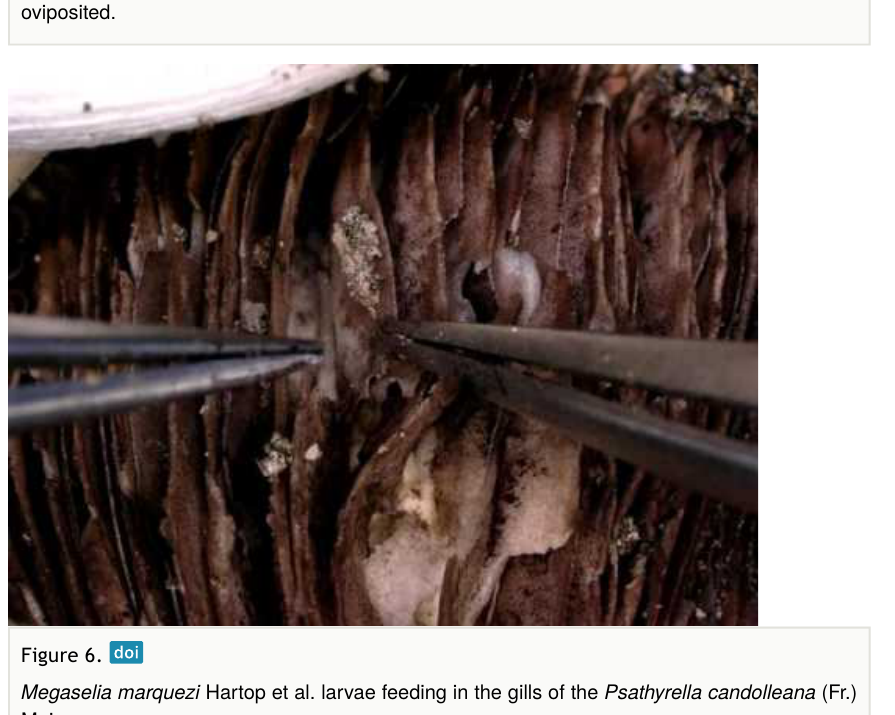
Figure 5. Megaselia marquezi Hartop et al. inside the broken-open cap of a closed Psathyrella candolleana (Fr.) Maire. Based on the extended abdomen, she appears to have just oviposited.